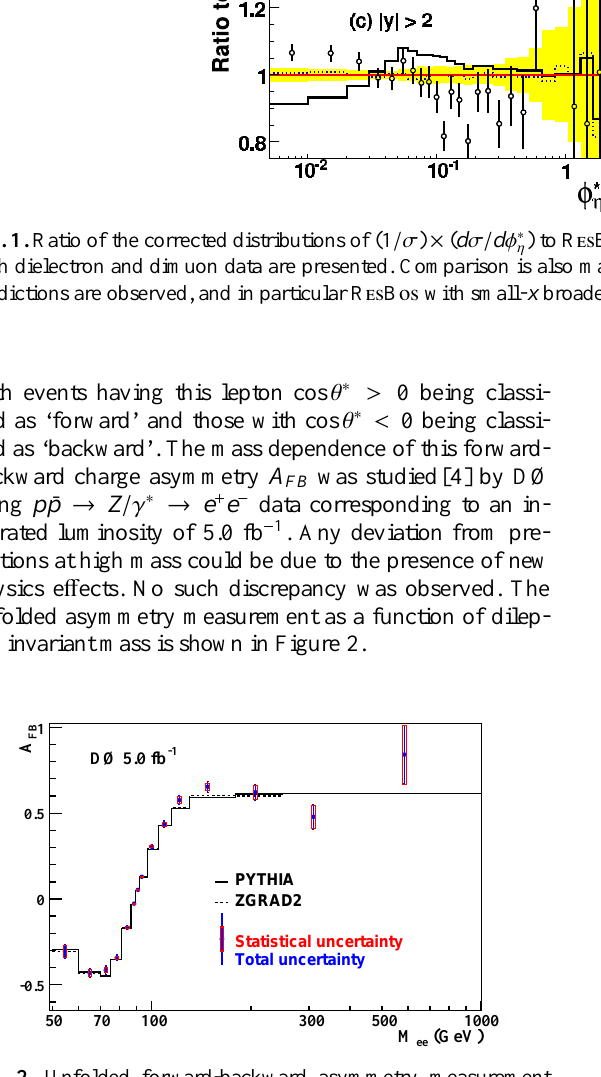
Fig. 2. Unfolded forward-backward asymmetry measurement (points) compared with predictions from pythia (solid line) and zgrad 2 (dashed line). No significant departure from expectation < 1000 GeV studied. is observed across the range 50 < M e + e − Fig. 3. The 68% C.L. contours of the measured vector and axial- vector couplings of the (a) up-quark and (b) down-quark to the Z boson compared with prior measurements. The DØ data con- tours are presented for both a two-dimensional fit, fixing the u ( d ) couplings to the Standard Model values while fitting the d ( u ) couplings, and a simultaneous four-dimensional